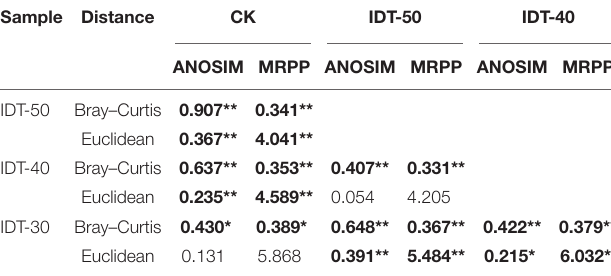
347 nodes and 647 edges ( Supplementary Table 2 ).